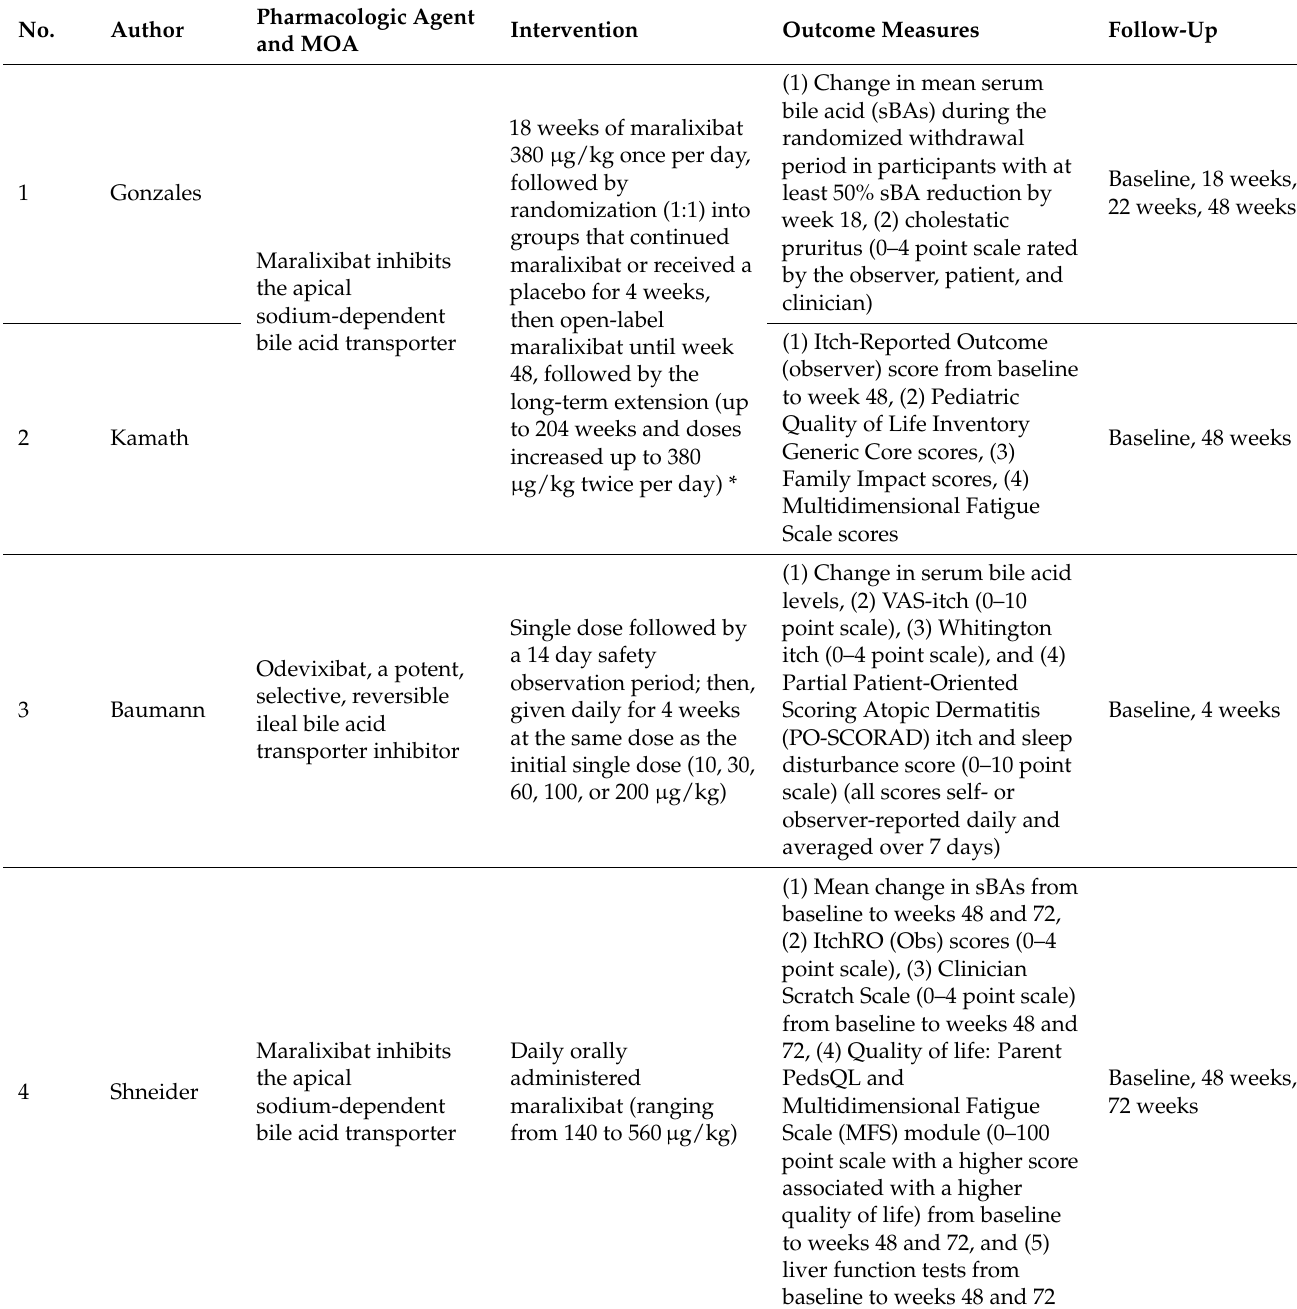
Table 2. Baseline characteristics of the included